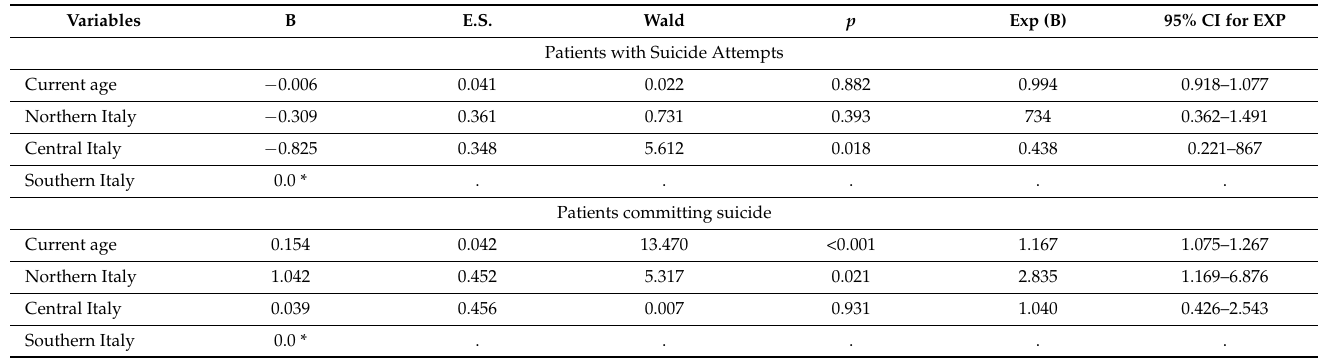
Table 4. Multinomial regression evaluating the predictive power of sociodemographic characteristics on the suicide-related variables.